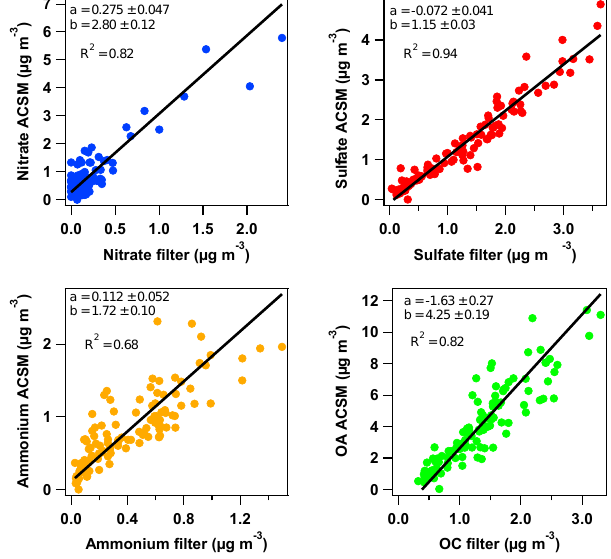
centrations. Lines and parameters correspond to least orthogonal distance